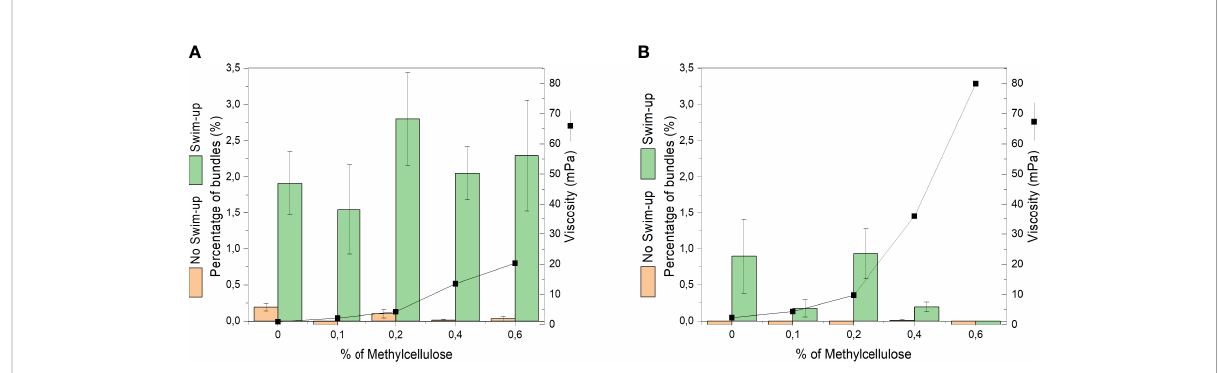
FIGURE 2 Occurrence of cell bundles as percentage of total number of bull sperm before and after swim-up in different levels of viscosity (different concentrations of methyl cellulose). Viscosities are average values at shear rate 100 1/s. (A) DMEM (B) DMEM medium + BSA